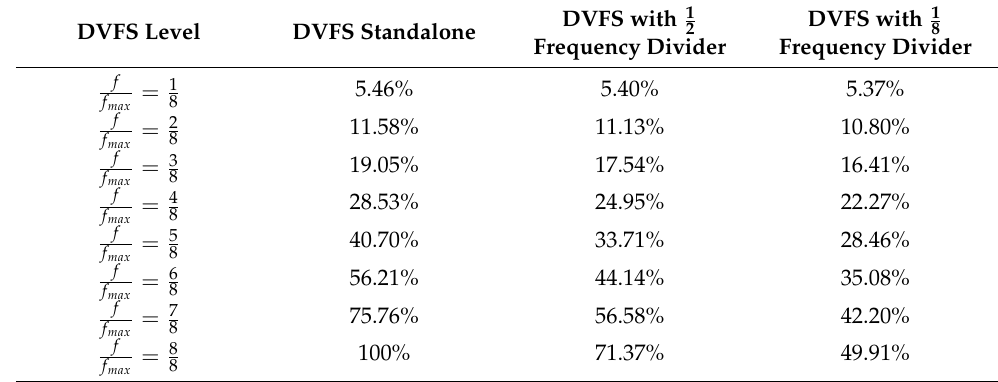
Table 1. Comparison of power consumption between DVFS standalone with DVFS adding fre- quency